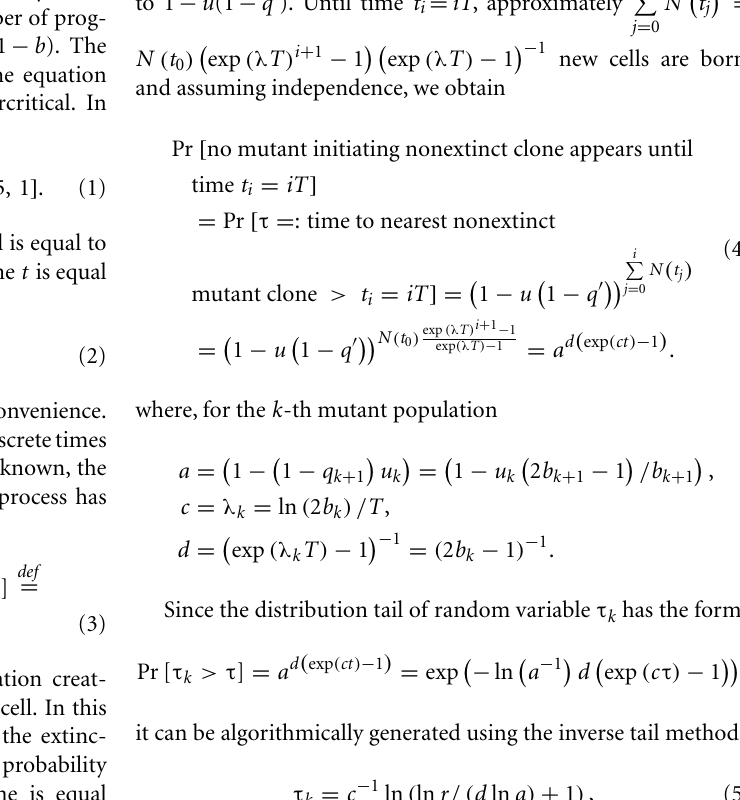
FIGURE 1 | Dynamic stochastic model of impaired differentiation in granulocyte precursors. GCSF signaling occurs through its cognate receptor, GCSFR. It involves both proximal signaling networks consisting of signaling molecules such as Lyn, Jak, STAT, Akt, and ERK, and distal gene regulatory networks consisting of transcription factors.Together,